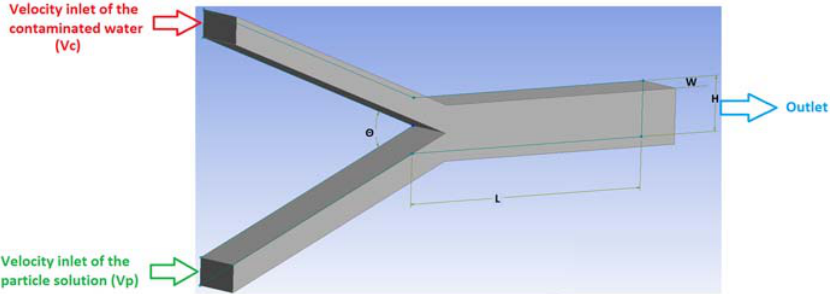
Figure 1. Micromixer geometry of the Y ‐ shaped duct and water ‐ particles inlet and outlet flow directions. θ is the angle between the two inlet